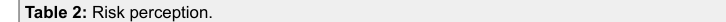
Table 2: Risk perception. Answer to the statement “the use of dietary supplements does not present any risks” (n = 114). n %